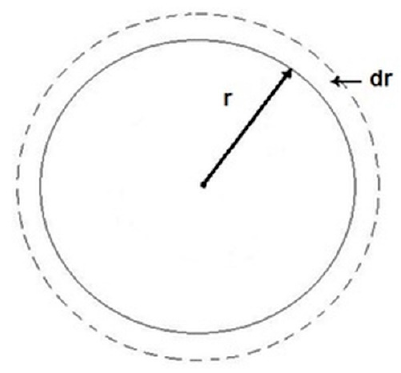
Figure 2. The reconstructed μ -CT image of the yellow ligament (stenotic group) with two threshold values. The upper threshold value (gray) refers to the soft tissue, the lower value (black) is mineral grain. Measurement with a resolution of 13.5 μ m. The area measured with a resolution of 2 μ m is marked. A two-dimensional cross-section of this area with the thresholding described above is shown [30].